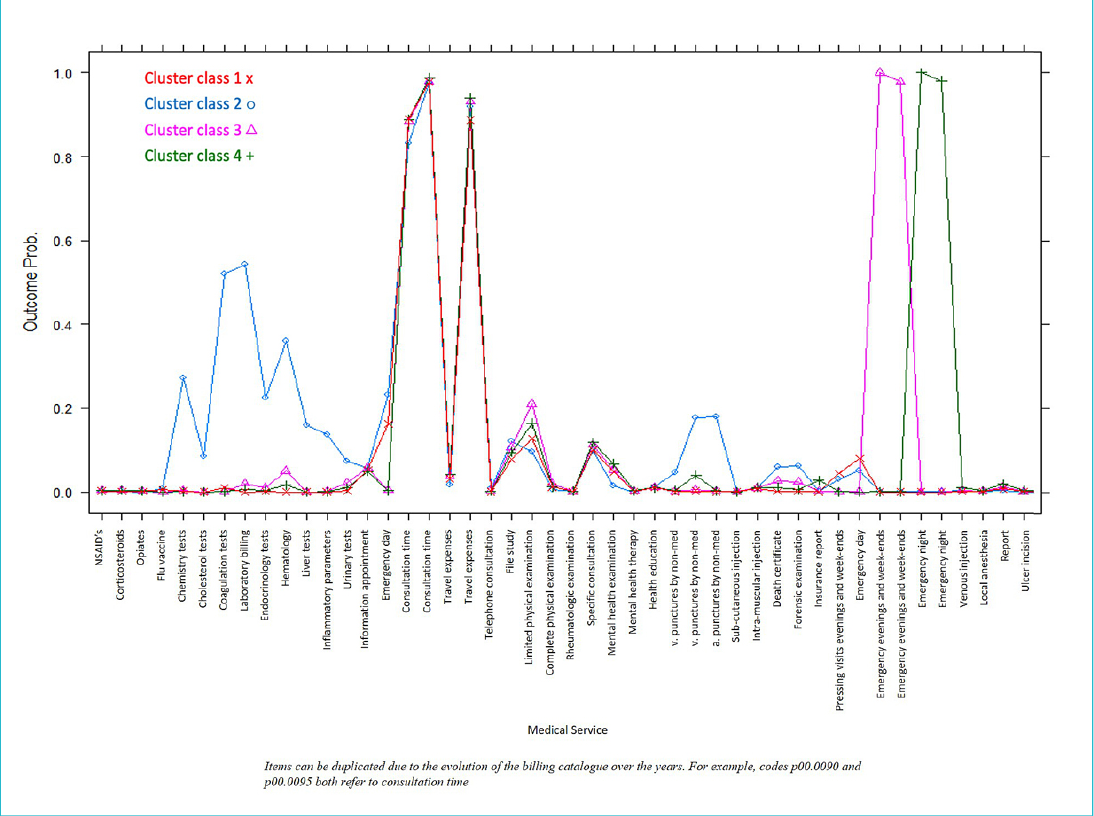
Figure 4: Specific billing items corresponding to the four cluster classes of home visits.